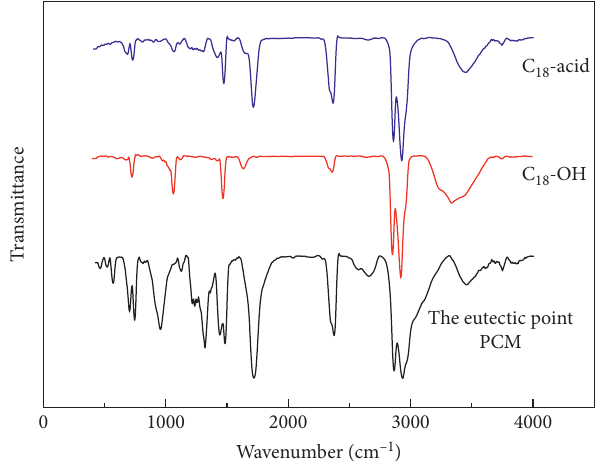
18 -acid, C 18 -OH, and the eutectic point